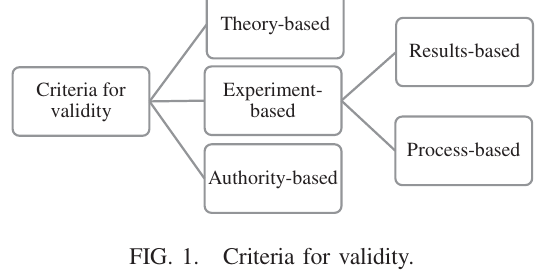
FIG. 1. Criteria for validity.